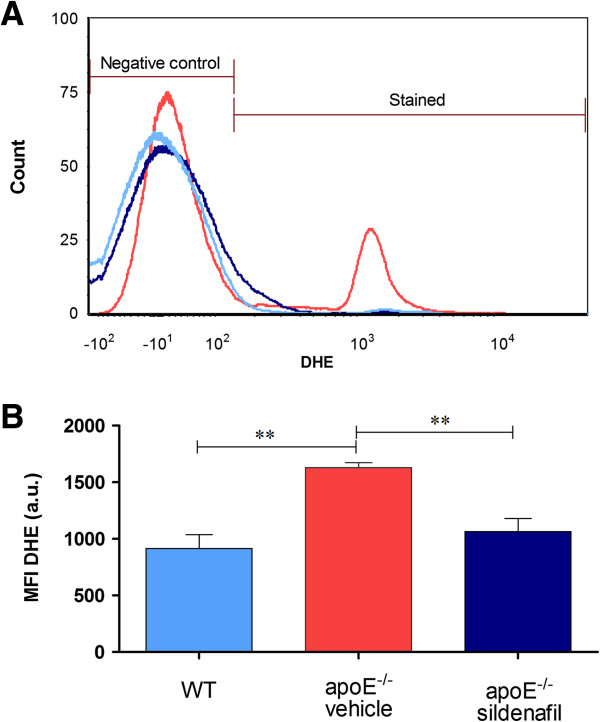
Effect of sildenafil treatment on superoxide anion production in MNC of apoE-/- mice. (A) Representative histogram from flow cytometric analysis using dihydroethidium (DHE) in control C57 wild-type (WT), apoE-/- vehicle and apoE-/- sildenafil; the log fluorescence (X axis) illustrates the intensity of fluorescence for the number of cells counted (note the higher scales in the apoE-/- vehicle histogram). A remarkable increase in the level of superoxide anions was observed in apoE-/- vehicle. Line colors correspond to bar colors below. (B) Bar graph showing mean fluorescence intensity (MFI, in a.u.). The values are presented as means ± SEM; 6 to 8 animals per group. **p < 0.01, ANOVA).